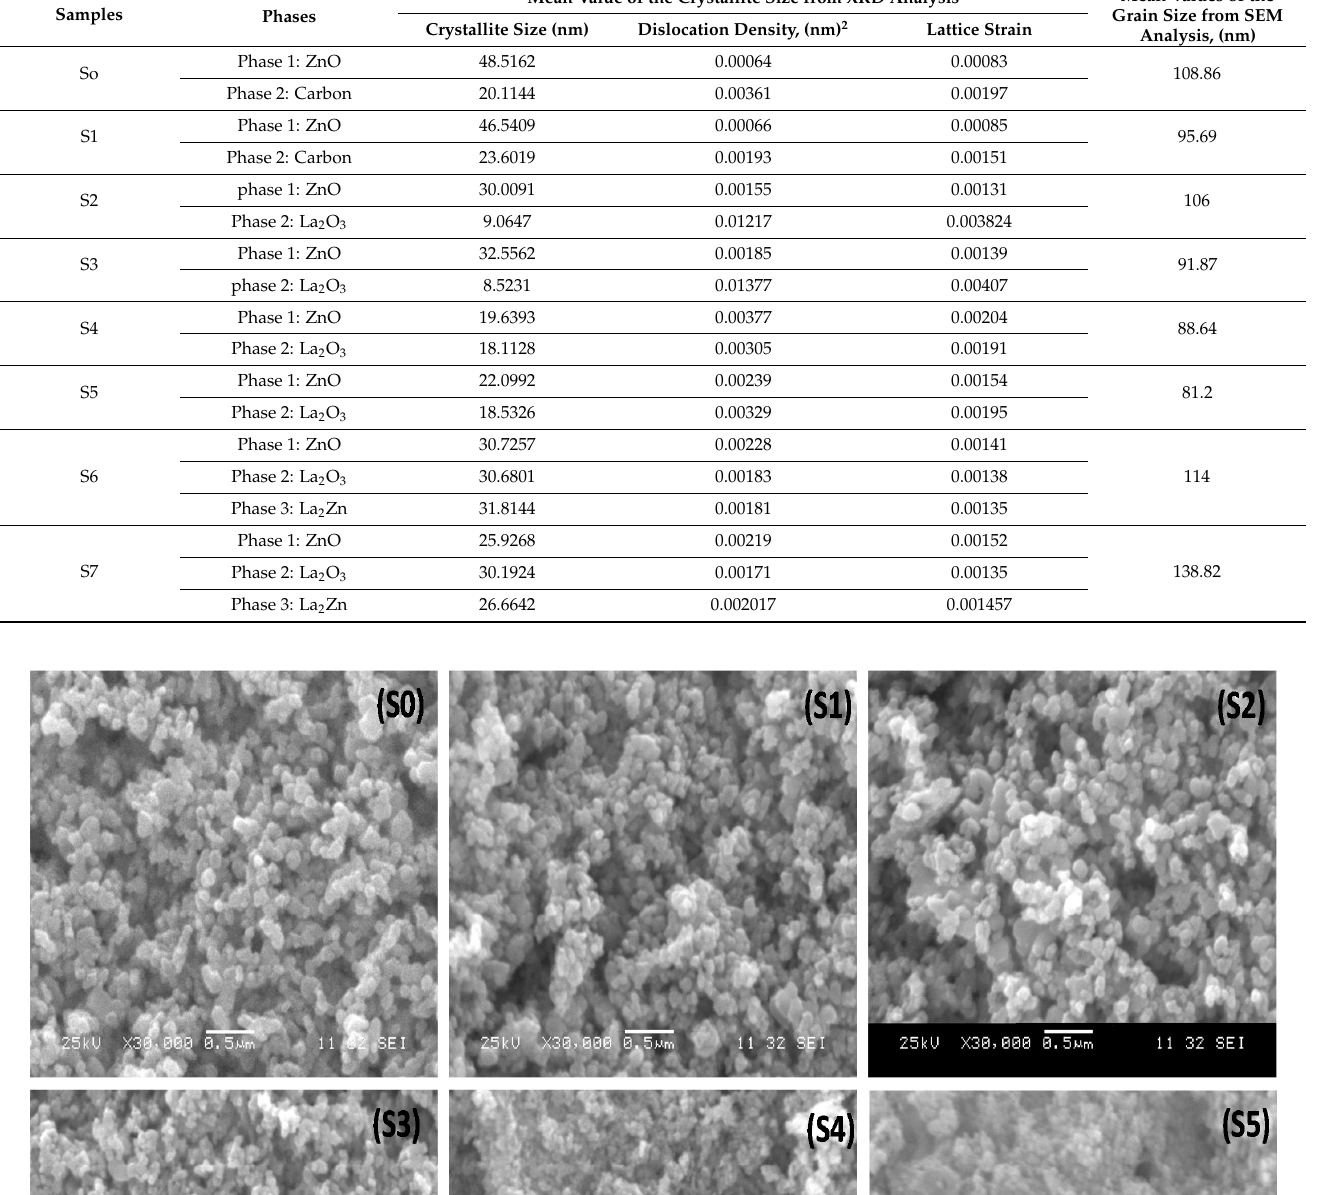
Table 2. A comparison of the XRD-derived crystallite size, dislocation density, and lattice strain. Mean Value of the Crystallite Size from XRD Analysis Mean Values of the